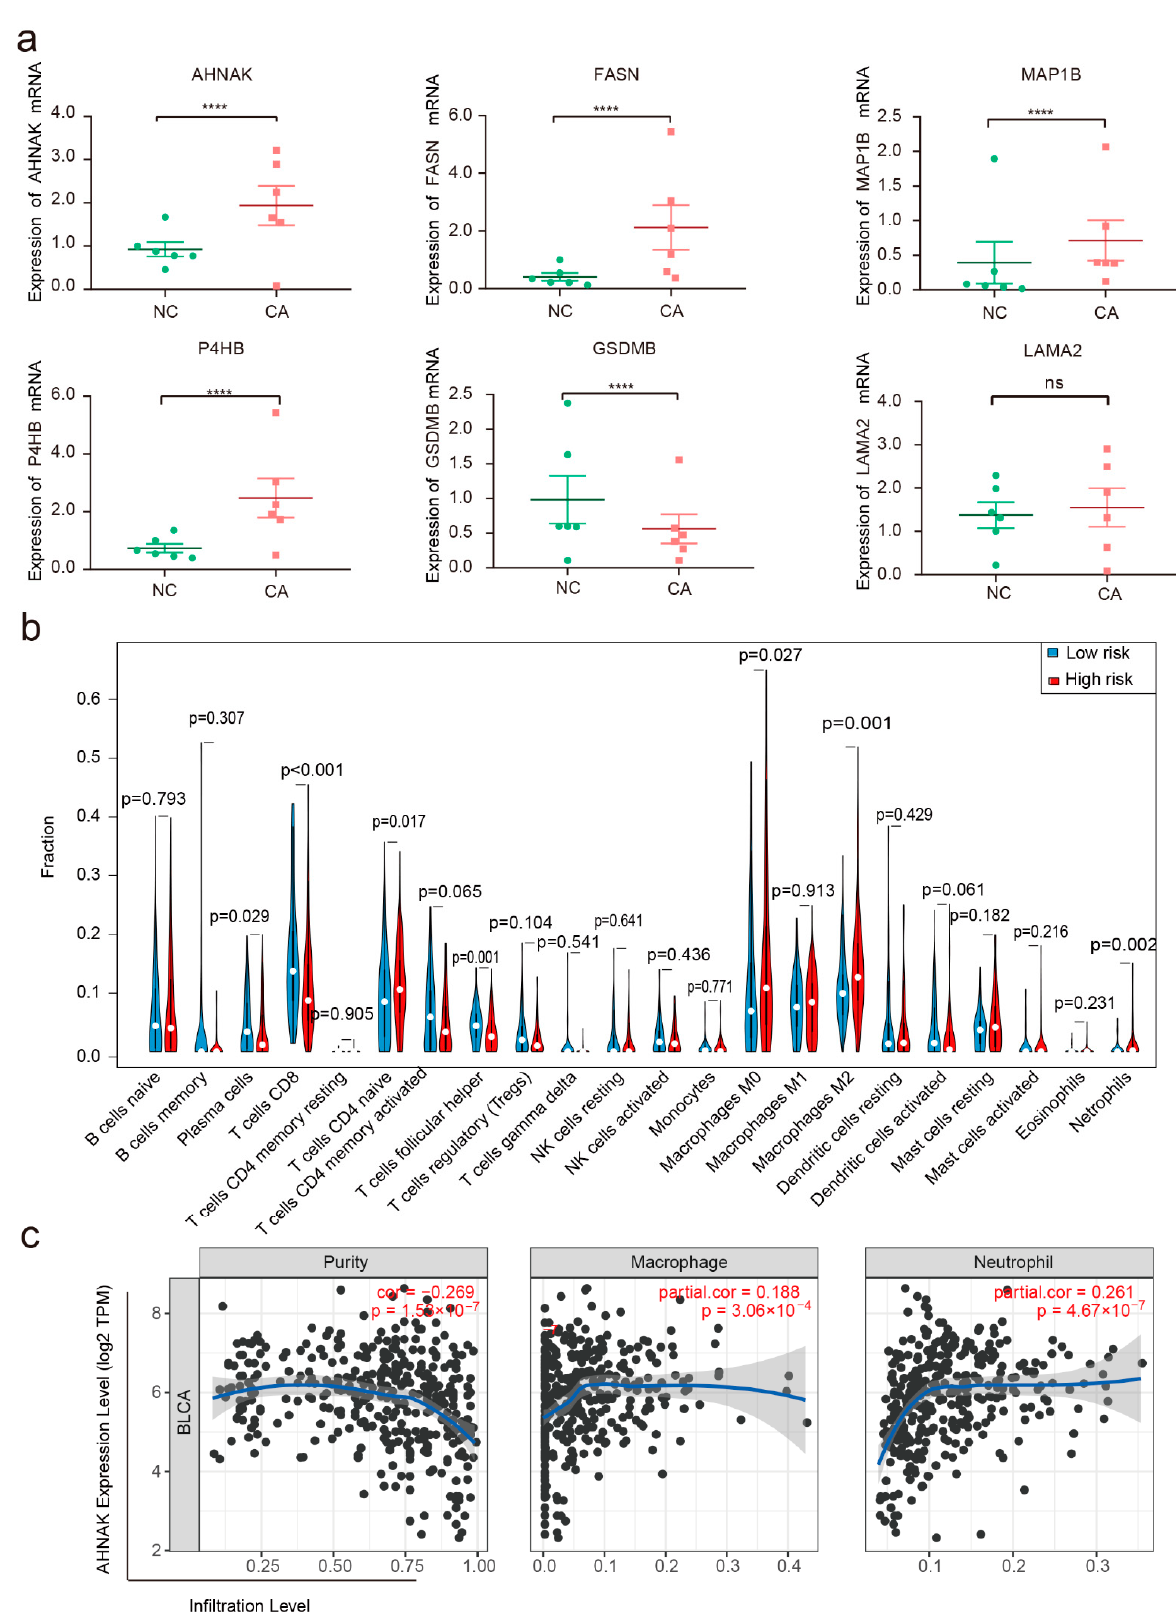
Figure 5. Expression of the six RBPs in tumor tissue and the immune microenvironment. ( a ) The RNA expression patterns of the six RBPs in BC types and paired non-tumor samples. Each red